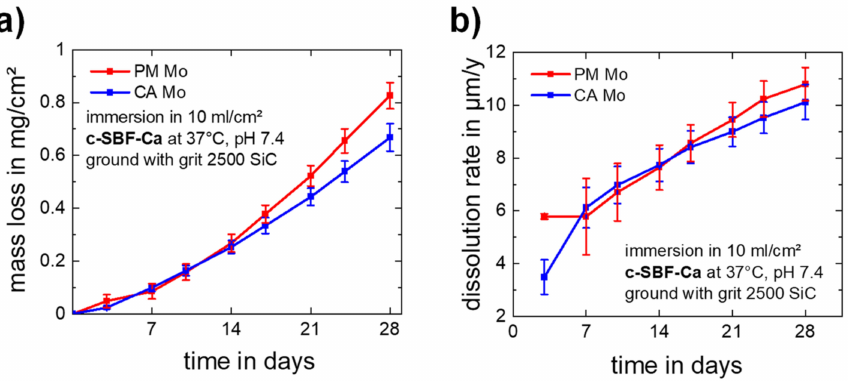
Figure 3. Ion concentration-derived progression of mass loss ( a ) and dissolution rates ( b ) for CA Mo and PM Mo over 28 days of immersion in